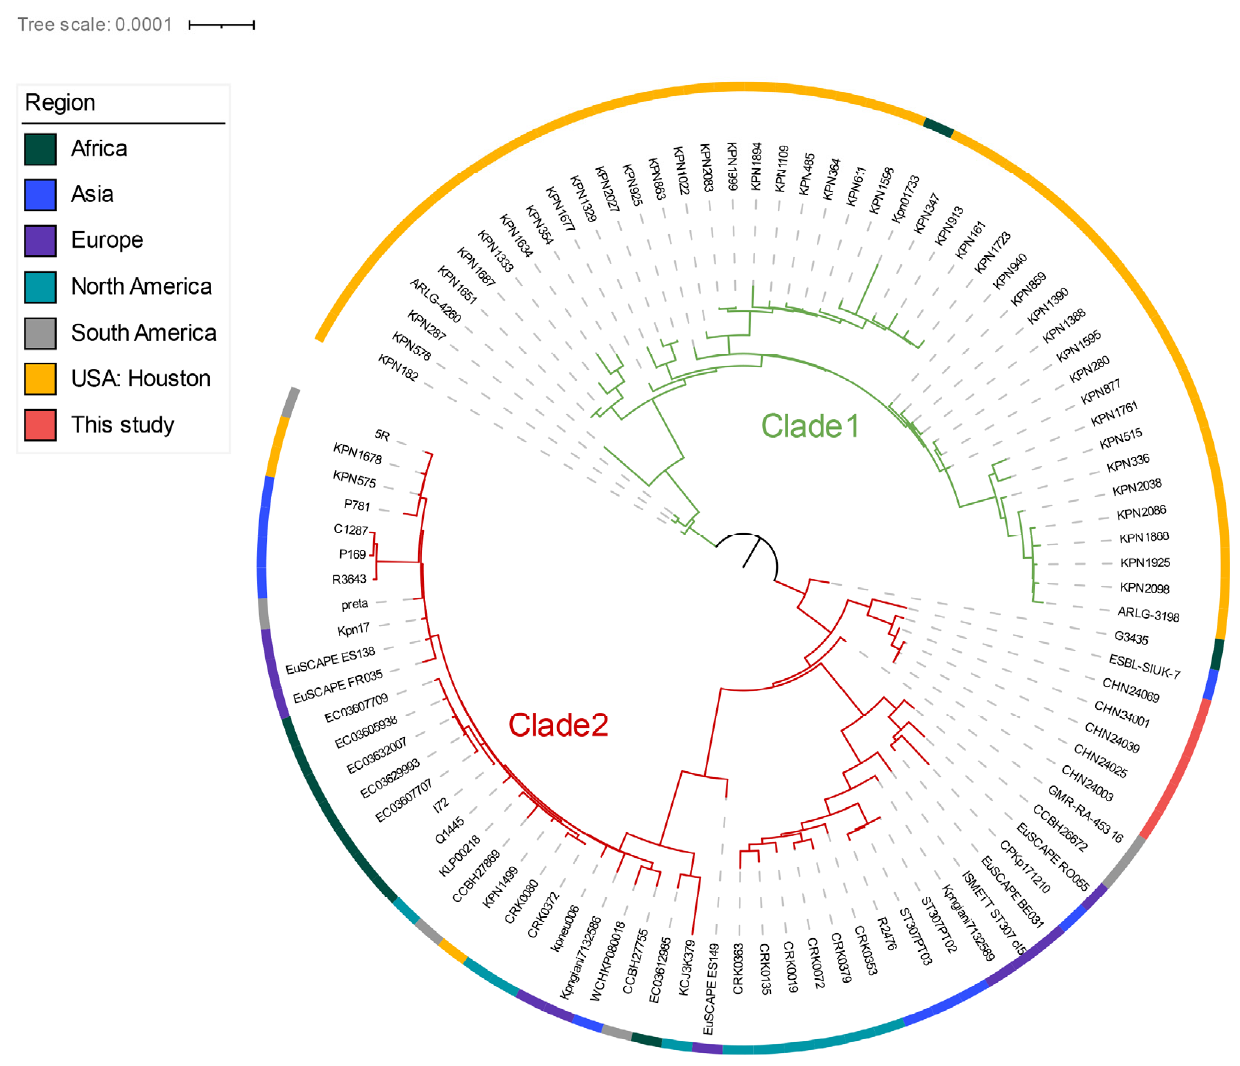
Figure 1. Population structure of ST307 worldwide along with the ST307 isolates in this study. Maximum-likelihood inferred phylogeny of ST307 isolates using strain C234 as a reference for core gene alignment with midpoint rooting. The branch label background corresponds to clades 1 and 2, and the outer ring indicates the region where the isolate was collected.